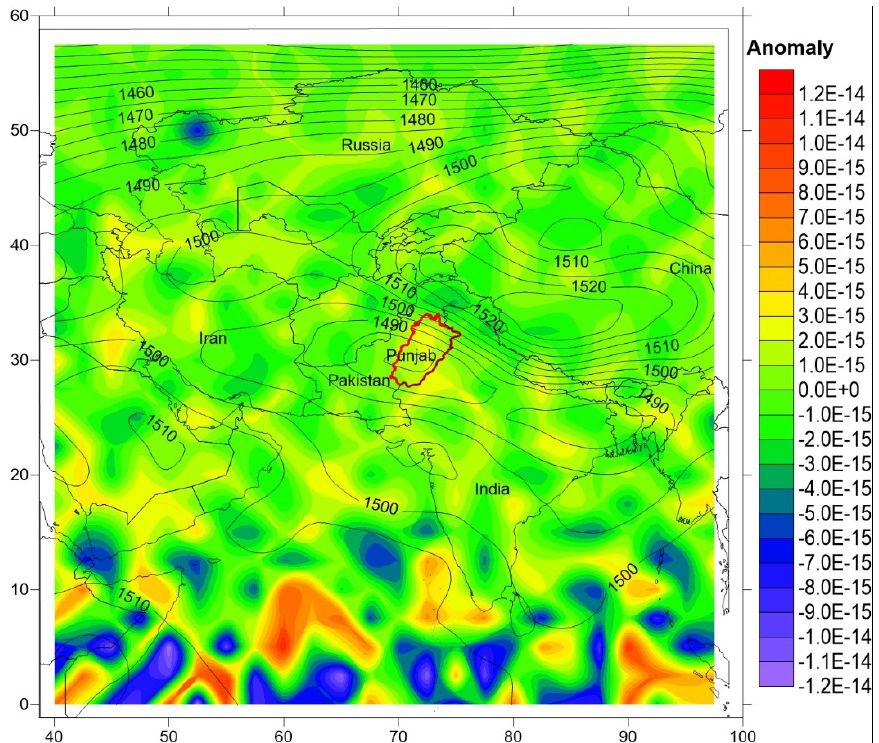
Figure 10. The anomaly of the 850 hPa HGT (shaded) and the mean of the 850 hPa HGT (contour) during 1979–2014.